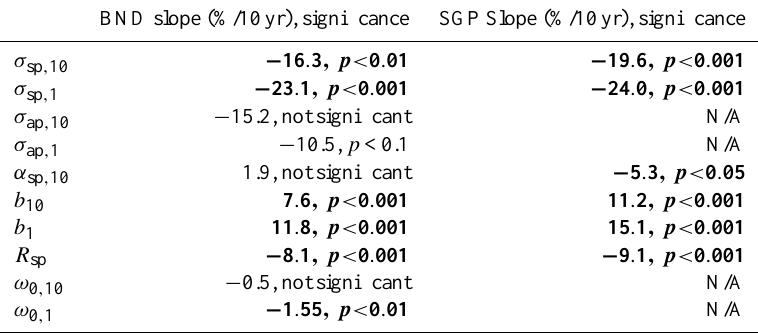
Table 4. Mann–Kendall slopes (%/decade) and trend significance ∗ for long-term trends in several PM 10 and PM 1 aerosol optical properties measured at BND and SGP. Monthly averaged data are used for the calculations. BND data for the time period 1996–2013 are used; SGP data for the time period 1997–2013 are used. Trends that are significant at or above the p <0.05 level are in bold. BND slope (%/10yr), significance SGP Slope (%/10yr), significance σ sp , 10 − 16 . 3 , p < 0 . 01 − 19 . 6 , p < 0 . 001 σ sp , 1 − 23 . 1 , p < 0 . 001 − 24 . 0 , p < 0 . 001 σ ap , 10 − 15.2, not significant N/A σ ap , 1 − 10.5, p <0.1 N/A α sp , 10 1.9, not significant − 5 . 3 , p < 0 . 05 b 10 7 . 6 , p < 0 . 001 11 . 2 , p < 0 . 001 11 . 8 , p < 0 .